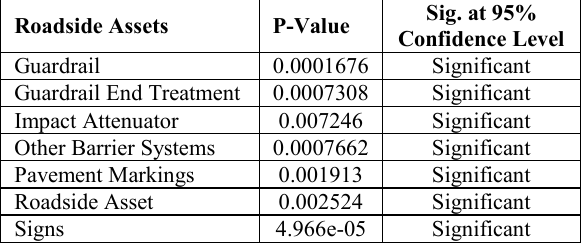
Table 3 . Results of Wilcoxon Test for Data Format usage across the different assets of the Roadside Asset Systems.